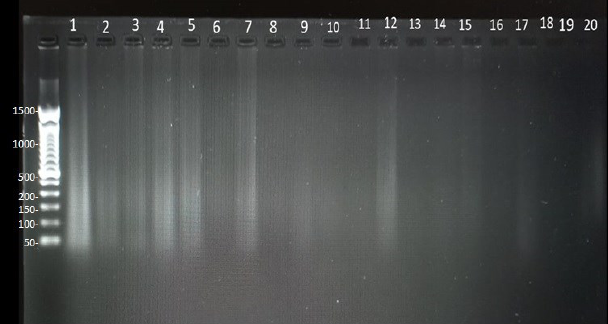
Fig.2: Electrophoresis assay for DNA extraction from twenty biological samples. The heterogeneity of fluorescence is evident in the lanes. Molecular weights in the witness lane (left side) are in Kpb.